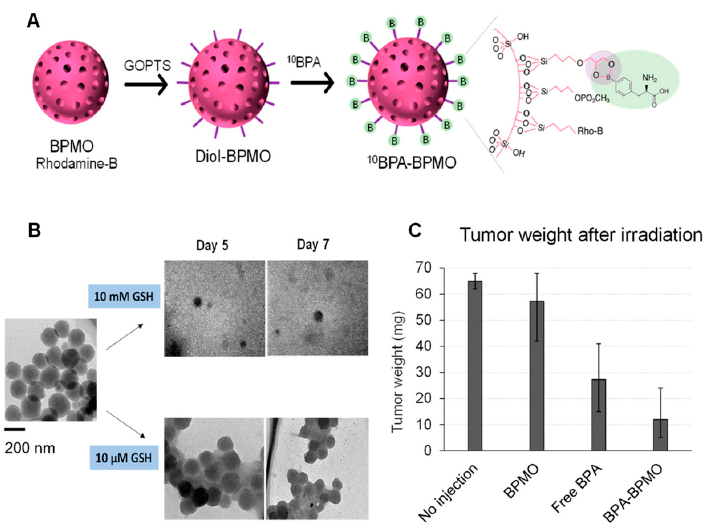
Figure 12. ( A ) Schematic representation of bridged, biodegradable MSNs functionalized with boronophenylalanine on the surface for BNCT. ( B ) The NPs degraded almost completely after 7 days in the presence of GSH. ( C ) Great tumor reduction was observed in the group of irradiated NPs. Adapted with permission from [68]. Copyright MDPI, 2021.